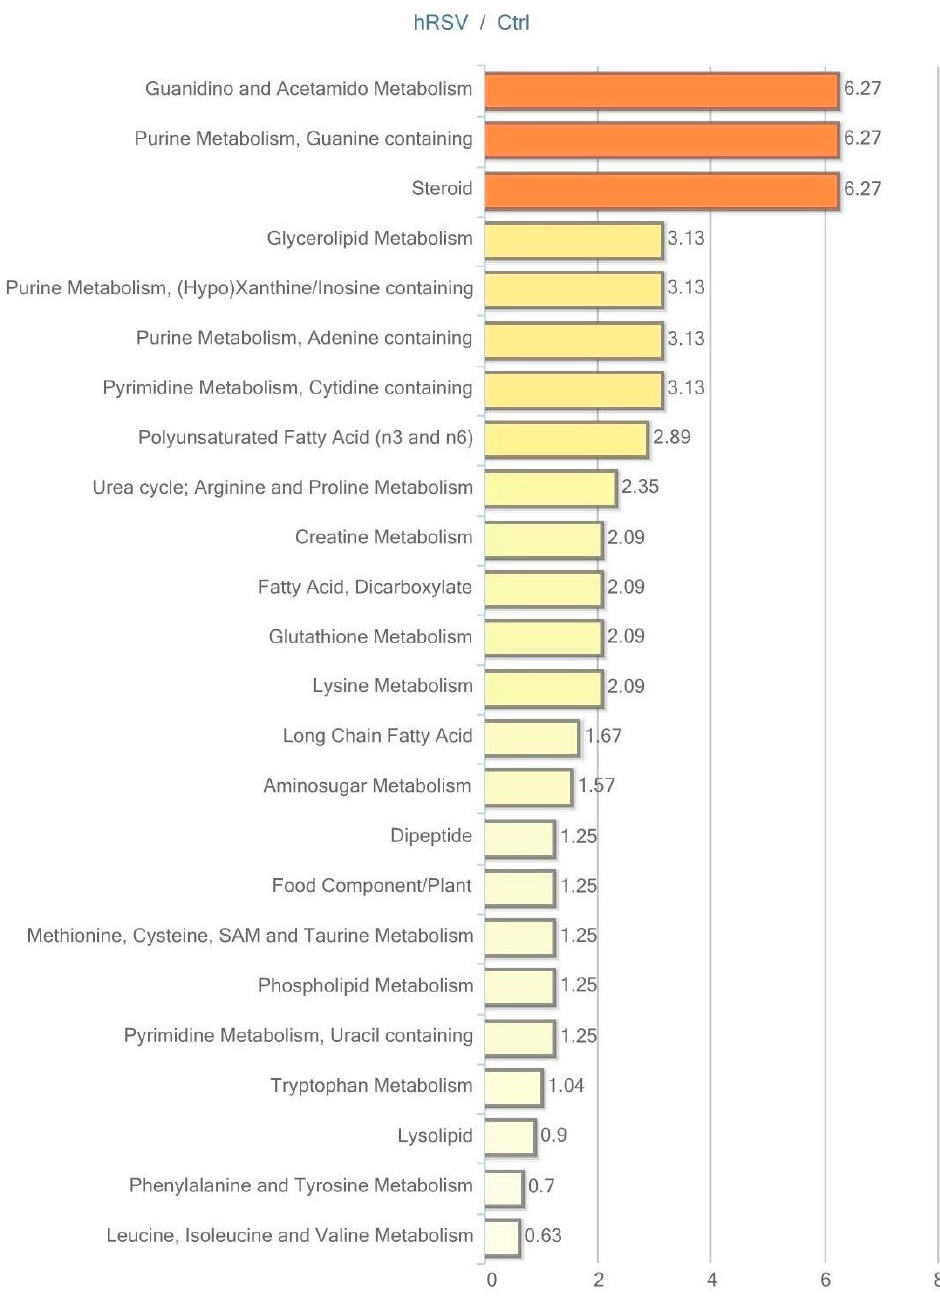
Figure 3. Resveratrol-mediated changes in adipose tissue, expressed as Pathway enrichment values (PEV). Values are based on the significant resveratrol-regulated compounds relative to all detected compounds in the pathway. PEV = (number of significant metabolites in pathway/total number of detected metabolites in pathway)/(total number of significant metabolites/total number of detected metabolites); hRSV: high-dose resveratrol; Ctrl: Placebo group.